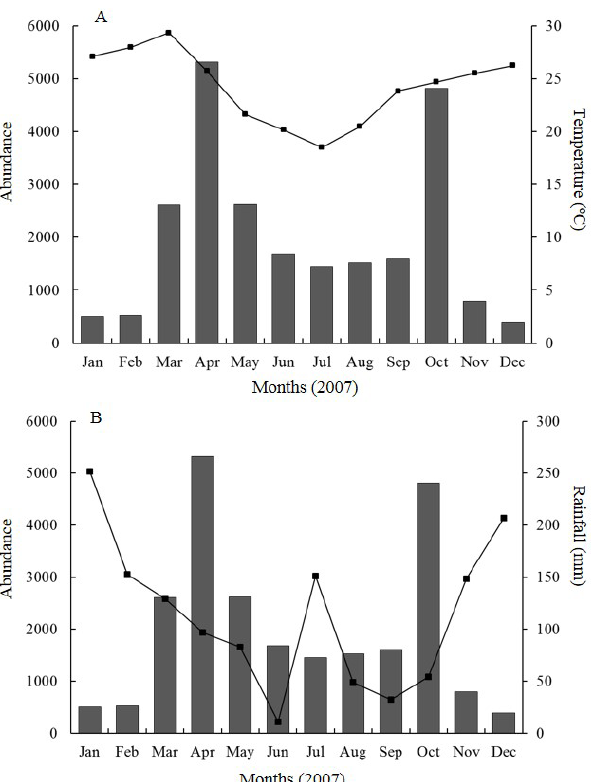
Figure 5. Relationship between the abundance of Macrobrachium olfersii with temperature ( A ) and rainfall ( B ), in Ribeira de Iguape river São Paulo, Brazil, from January to December 2007.